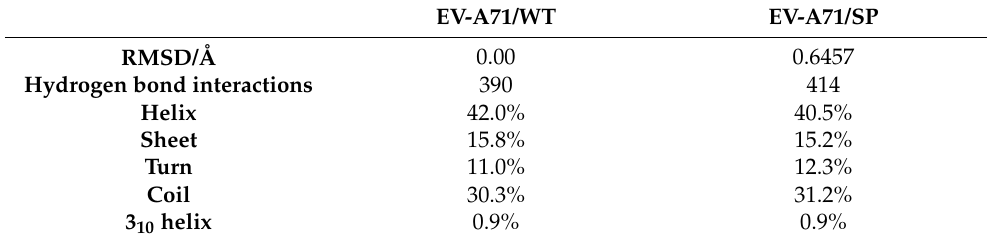
Table 5. Comparison analysis of the 3D pol structures between EV-A71/WT and